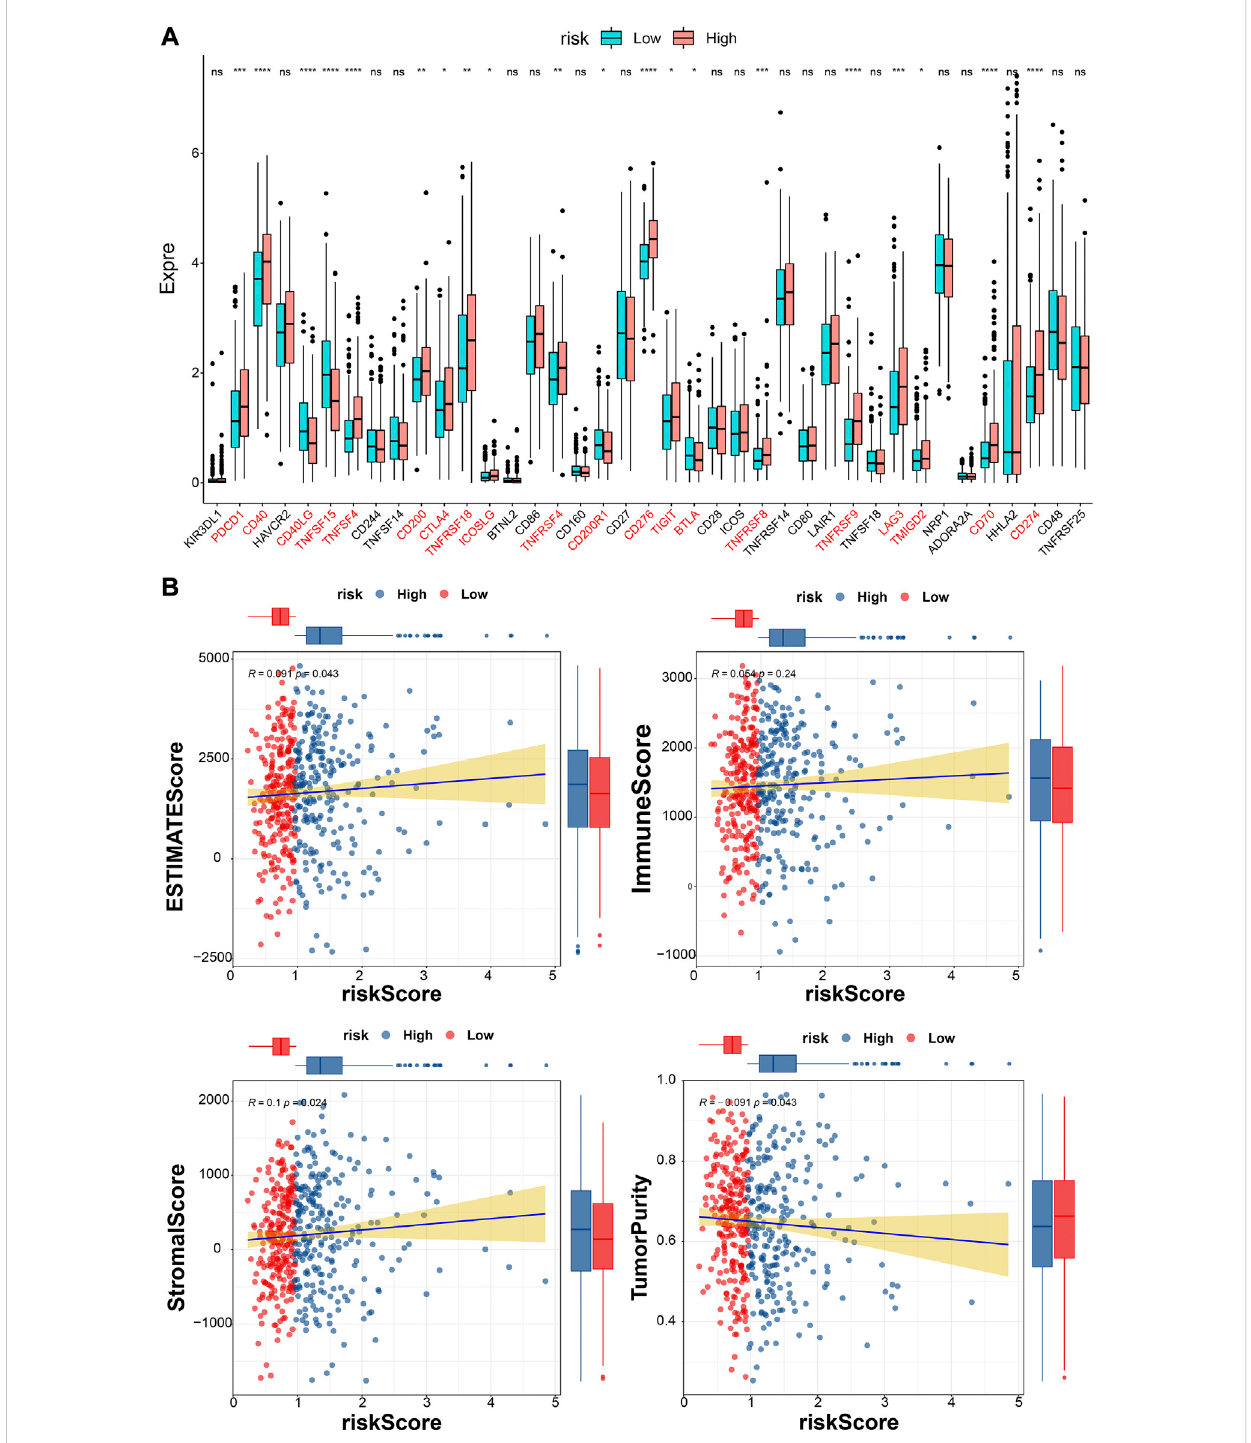
FIGURE 10 Analysesofimmunecheckpointandtumorimmunemicroenvironment. (A) TheexpressionsofICIsbetweenhigh-andlow-riskgroups(Wilcoxtest). * represents p < 0.05, ** represents p < 0.01, *** represents p < 0.001, **** represents p < 0.0001, and ns indcates no signi fi cance. (B) The correlations between estimate score, immune score, stromal score, tumor purity, and risk